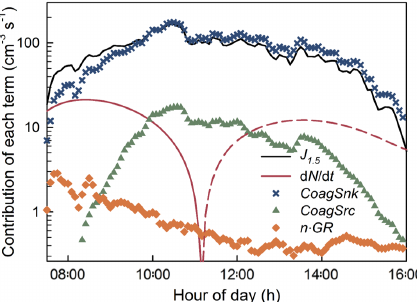
Figure 5. Contribution of each term to the estimated formation rate; d N / d t is obtained by fitting and shown as an absolute value with solid and dashed lines corresponding to positive and negative parts, respectively. Note that the upper bound, d u , equals d b as defined in Sect. 4.1 for better accuracy; however, it does not affect the gener- ality of the result.